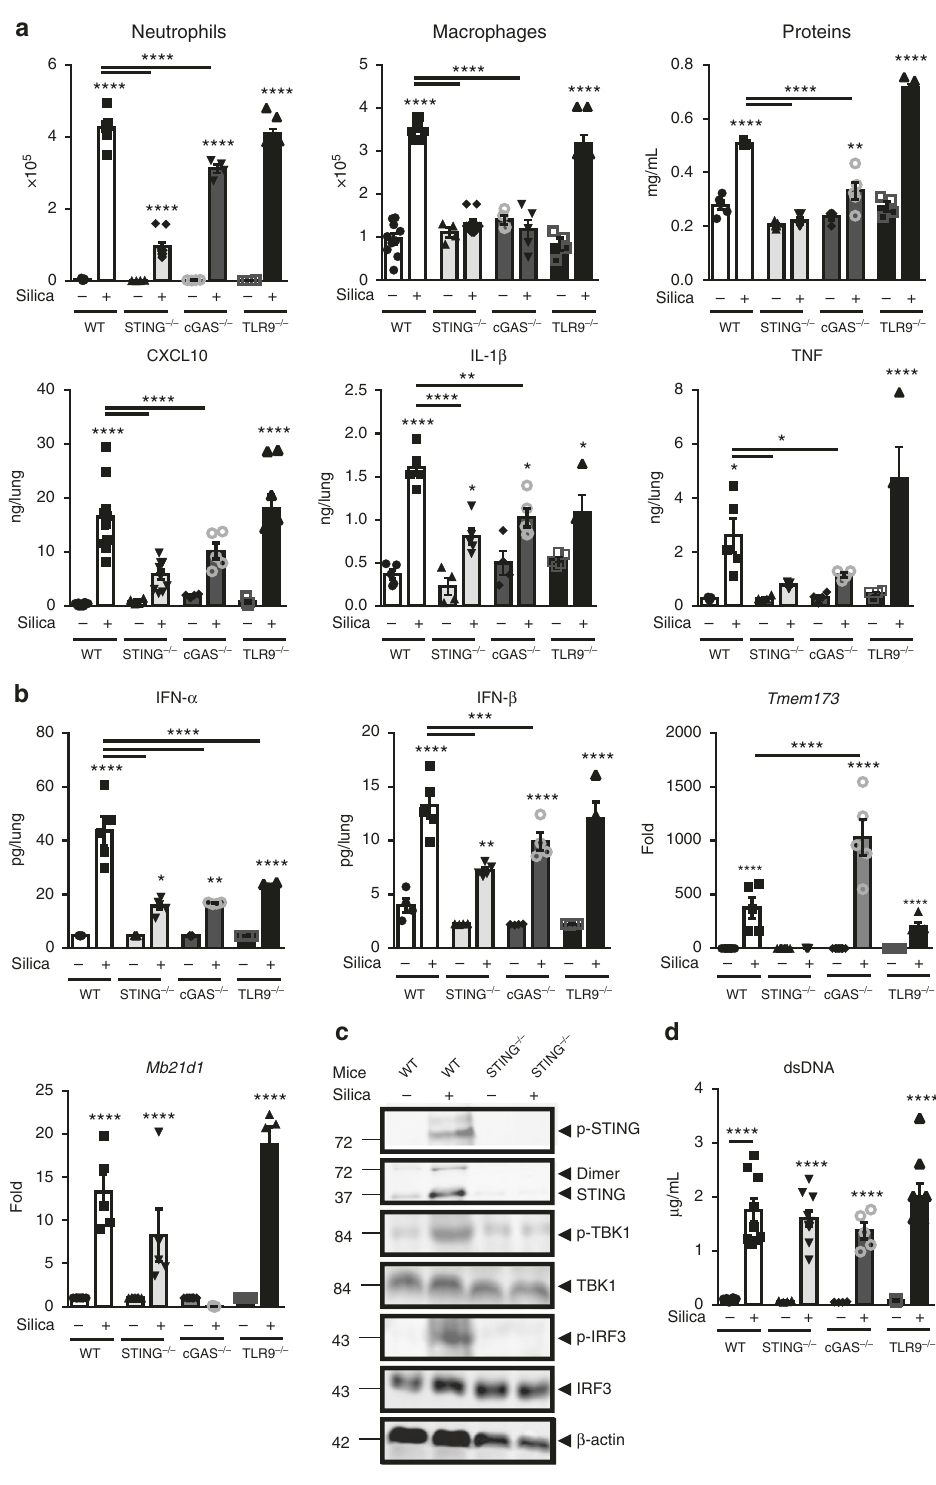
Fig. 3 DNA sensors STING and cGAS are essential, while TLR9 is dispensable, for silica-induced lung in fl ammation. Silica microparticles (1mg/mouse, i.t.) or saline vehicle were administered in WT, STING − / − , cGAS − / − , and TLR9 − / − mice and the different parameters were analyzed on day 7. a Neutrophils, macrophages, and protein extravasation were measured in the BALF and the lung levels of CXCL10, IL-1 β , and TNF were determined by ELISA. b Pulmonary IFN- α and IFN- β protein concentrations determined by multiplex immunoassay, and Tmem173 and Mb21d1 transcripts measured by real-time PCR. c Immunoblots of STING/IRF3 axis in the lung of WT and STING − / − mice, including phospho-STING, STING, phospho-TBK1, TBK1, phospho-IRF3, and IRF3, with β -actin as a reference. d Concentration of extracellular dsDNA in the acellular BALF fraction. * p <0.05, ** p <0.01, **** p <0.0001 (Kruskal – Wallis test followed by Dunn post test). Data are presented as mean±SEM and are representative of three ( a , b , d ) and two ( c ) independent experiments. ( a , b , d ): mice per group: n = 10 (WT NaCl), n = 8 (WT silica), n = 4 (STING − / − NaCl), n = 7 (STING − / − silica), n = 4 (cGAS − / − NaCl), n = 5 (cGAS − / − silica), n = 5 (TLR9 − / − NaCl), n = 6 (TLR9 − / − silica). Immunoblots are representative of n = 6 samples from two independent experiments ( c ). Each symbol represents an individual mouse. Source data are provided as a Source data fi